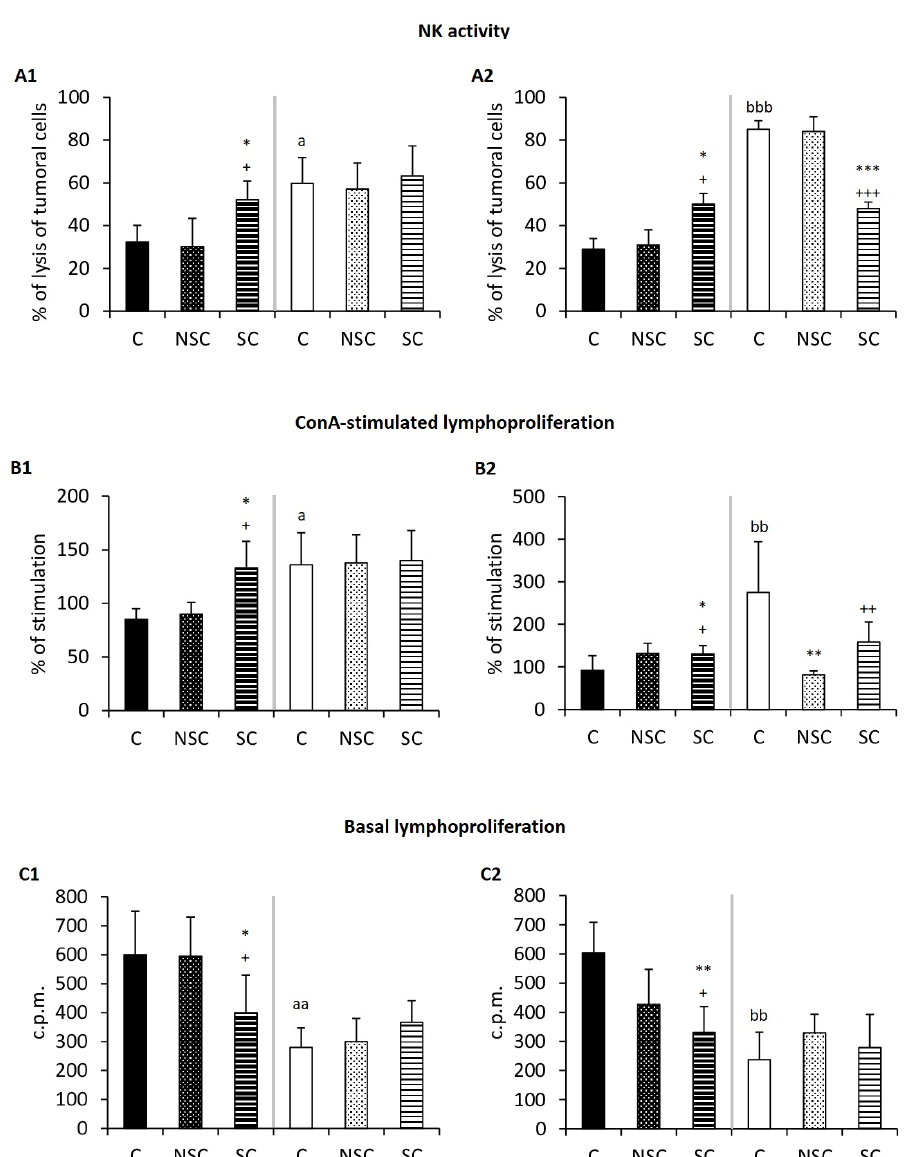
Figure 2. Changes in immune parameters. ( A ) Natural killer activity expressed as % of lysis of tumoral cells. ( B ) Percentage (%) of ConA-stimulated lymphoproliferation. ( C ) Basal lymphoproliferation in counts per minute (c.p.m.). The results corresponding to peritoneal leukocytes from chronologically adult and old mice are shown in A1, B1, and C1, and from adult prematurely-aging mice (PAM) and non-prematurely-aging mice (NPAM) are shown in A2, B2, and C2. Each column shows the mean ± standard deviation of 6–15 values corresponding to the same number of animals. After a statistical analysis comparing the means with the Student’s t -test for independent samples, significant differences were observed in the indicated experimental groups. *: p < 0.05, **: p < 0.01, ***: p ≤ 0.001 with respect to the values obtained in their corresponding control group. +: p < 0.05. ++: p < 0.01, +++: p ≤ 0.001 with respect to the values obtained in the corresponding NSC group. a: p < 0.05, aa: p < 0.01 with respect to the values obtained in old mice C. bb: p < 0.01, bbb: p < 0.001 with respect to the values obtained in PAM C. C: control group (old mice/PAM: n = 6. adult mice/E-NPAM: n = 7). NSC: non-skin-to-skin contact (old mice/PAM: n = 6; adult mice/E-NPAM: n = 15). SC: skin-to-skin contact (old mice/PAM: n = 6; adult mice/E-NPAM: n = 15). NK: natural killer. ConA: concanavalin. c.p.m.: counts per